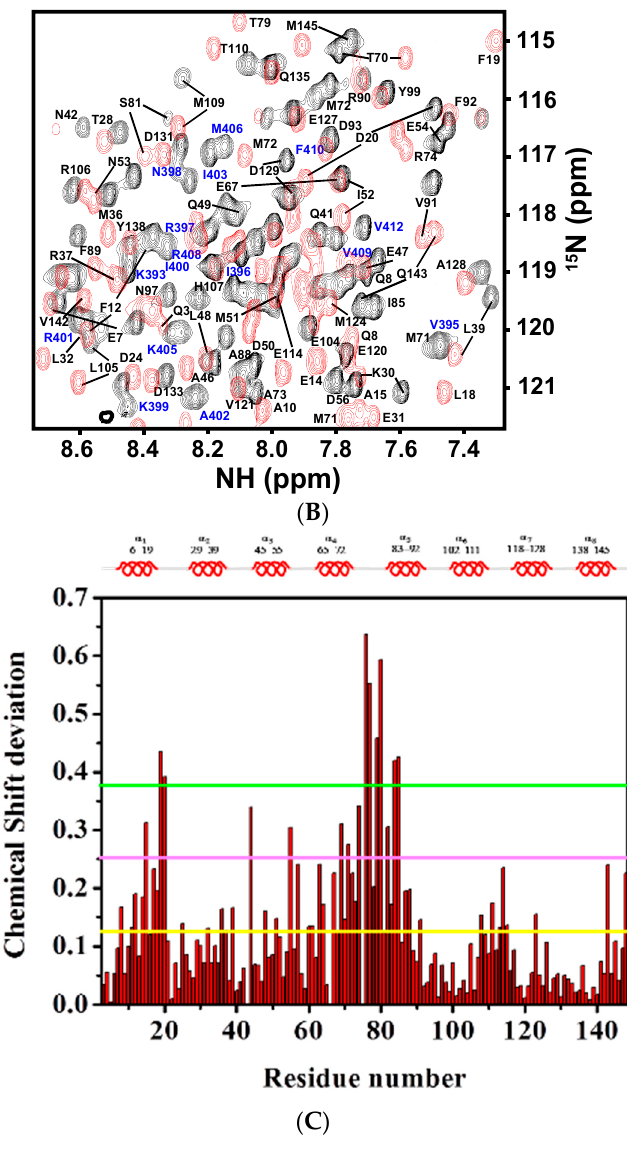
Figure 4. Two-dimensional 1 H- 15 N HSQC spectrum of CaM in complex with CaNp and chemical shift deviation. ( A ) The superimposed full 1 H- 15 N HSQC spectra of free CaM and CaM/CaNp complex. The spectra were acquired at 310 K in 20 mM KCl, at pH 6.5. The 1 H- 15 N crosspeaks of free CaM and CaM/CaNp were shown in red, and in black, respectively. Assignments of the 1 H- 15 N crosspeaks of CaM and CaNp are labeled in black and blue, respectively. The box region in the full spectrum was expanded and shown in ( B ) for the purpose of clarity; ( C ) The overall chemical shift perturbation, Δδ residue of CaM upon association with CaNp was plotted against residue number. Δδ residue of each residue was calculated as described in the Materials and Methods. The average of Δδ residue for all residues of CaM upon association with papain was calculated and shown as the yellow horizontal solid line (0.126 ppm). The magenta and green horizontal solid lines represented two- and three-fold averaged Δδ residue , respectively. The most deviated regions with chemical shift deviation larger than three-fold of average Δδ residue are located in helix 1 and central tether regions.